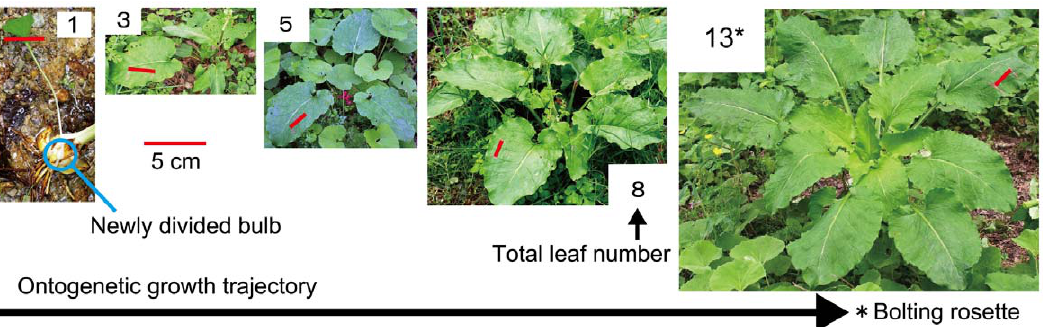
Figure 1. Ontogenetic growth trajectory of C . cordatum rosettes. The photographs show representative C . cordatum plants on 10 May 2010. Red scale bars superimposed on each photograph indicate a distance of 5 cm on each leaf. Leaf punch holes and ink markings used for other experiments appear on some of the leaves (photographs by K. Koyama, taken on 10 May 2010).